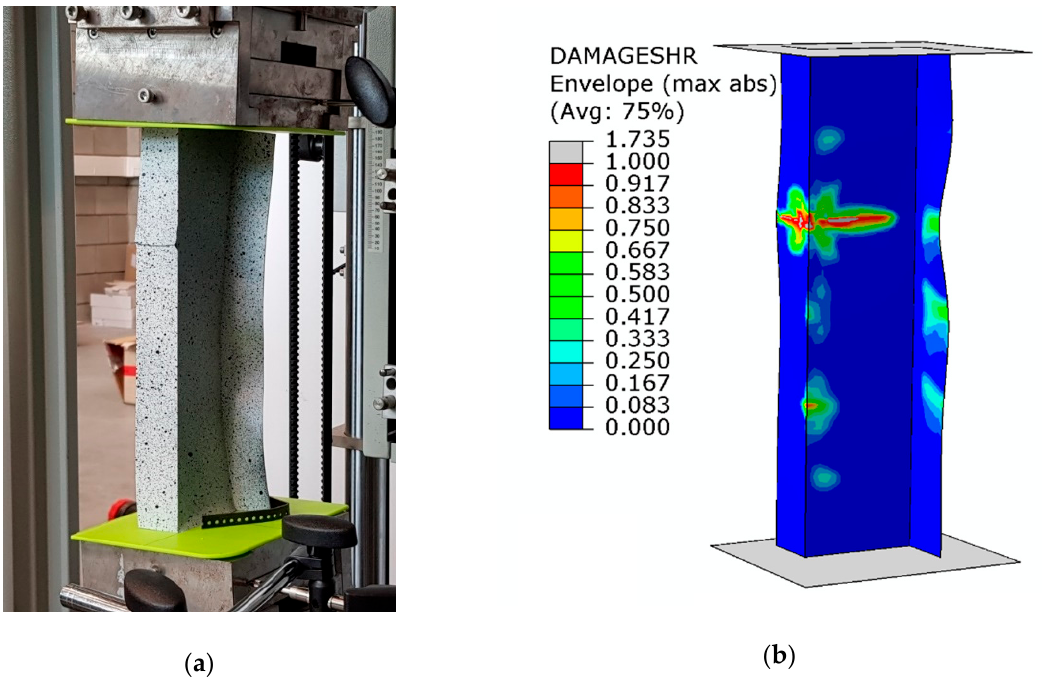
Figure 10. Buckling mode of the structure under the load eccentricity e 2 = 6 mm: ( a ) experimental; ( b ) numerical.